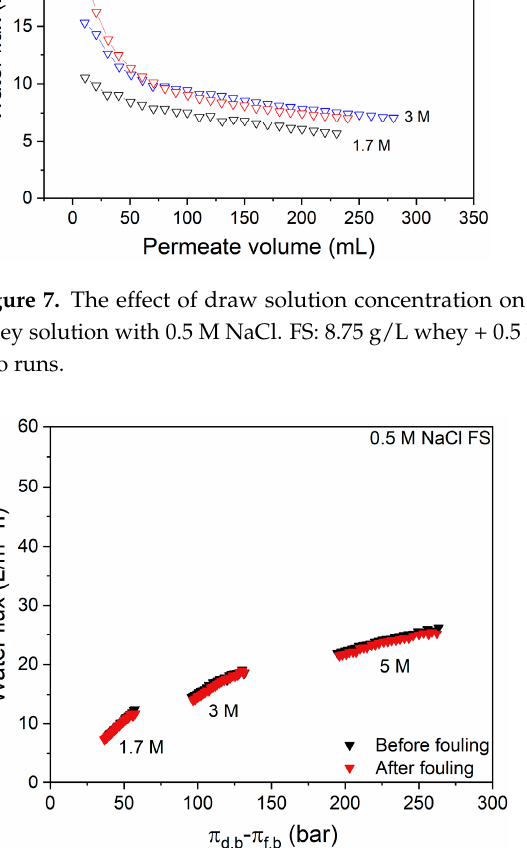
Figure 7. The effect of draw solution concentration on the water flux during the FO filtration of whey solution with 0.5 M NaCl. FS: 8.75 g/L whey + 0.5 M NaCl solution. Average values represent two runs.